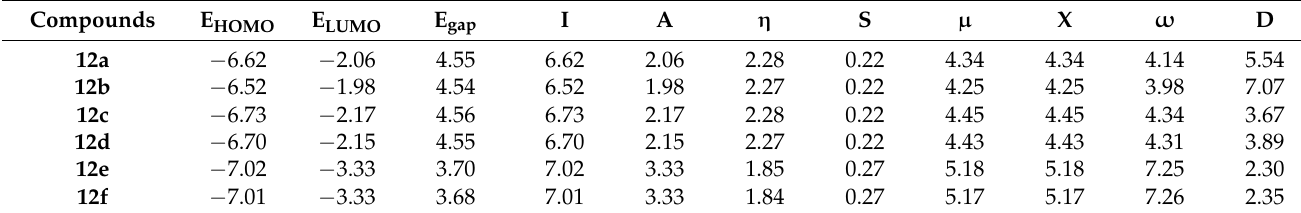
Table 2. Electronic parameters of synthesized compounds ( 12a–f